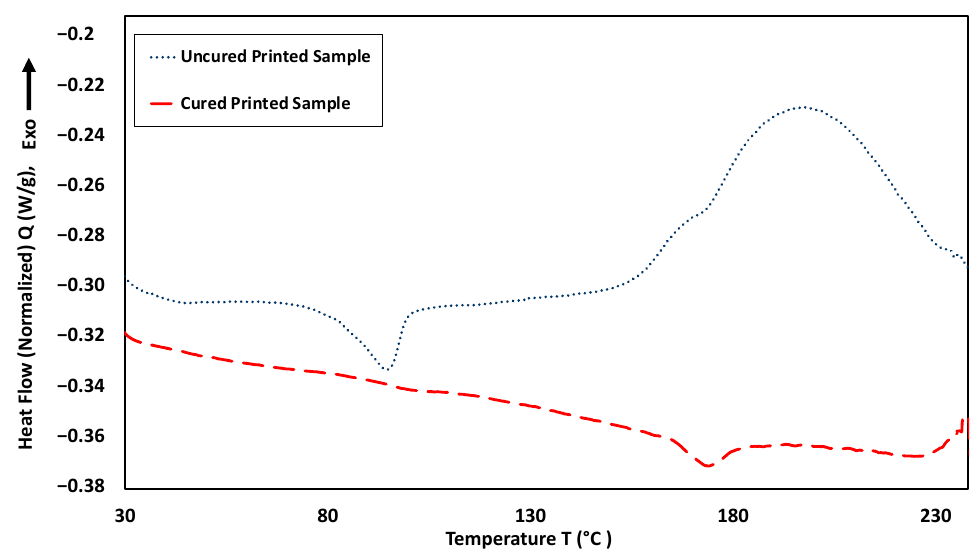
Figure 3. DSC Analysis of SLS printed epoxy thermoset sample. Endothermic peak indicates glass transition temperature (T g ). Exothermic area indicates enthalpy required for curing of epoxy thermoset.